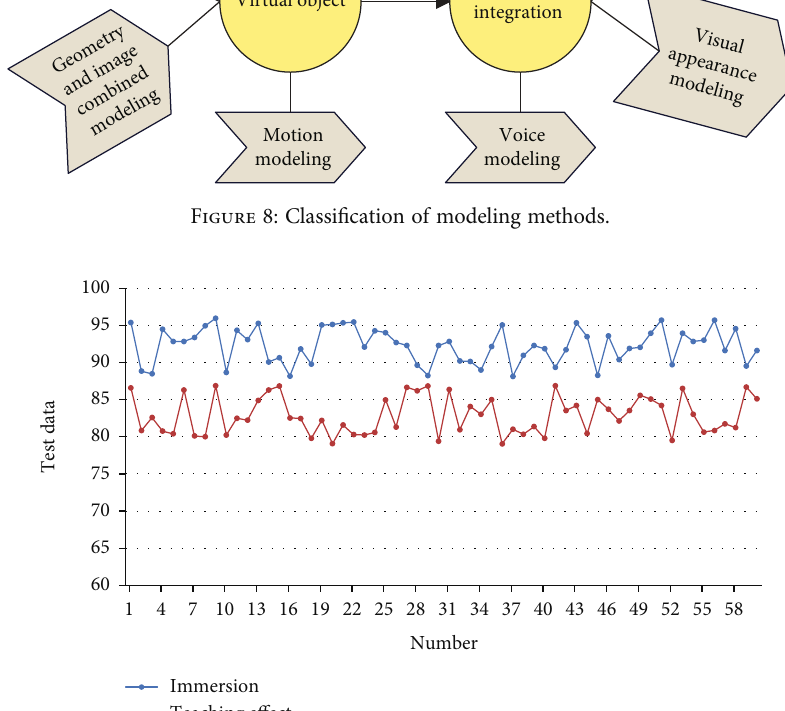
Figure 9: The application e ff ect of immersive interactive technology in animation